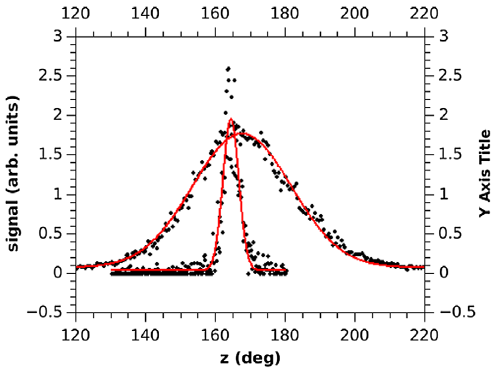
FIG. 7. Predicted stripping efficiency versus beam power for the design